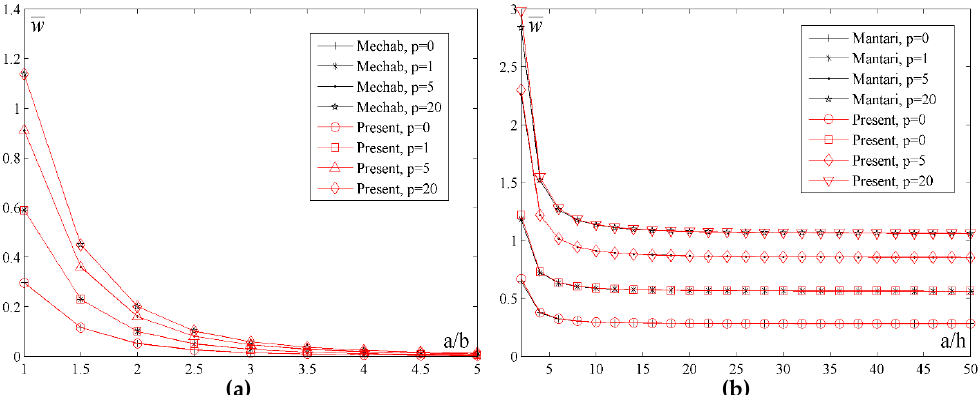
Figure 9. Normalized values of the displacement w for different a/h and a/b ratios and the values of the index p : ( a ) a/h = 10; ( b ) a/b = 1.